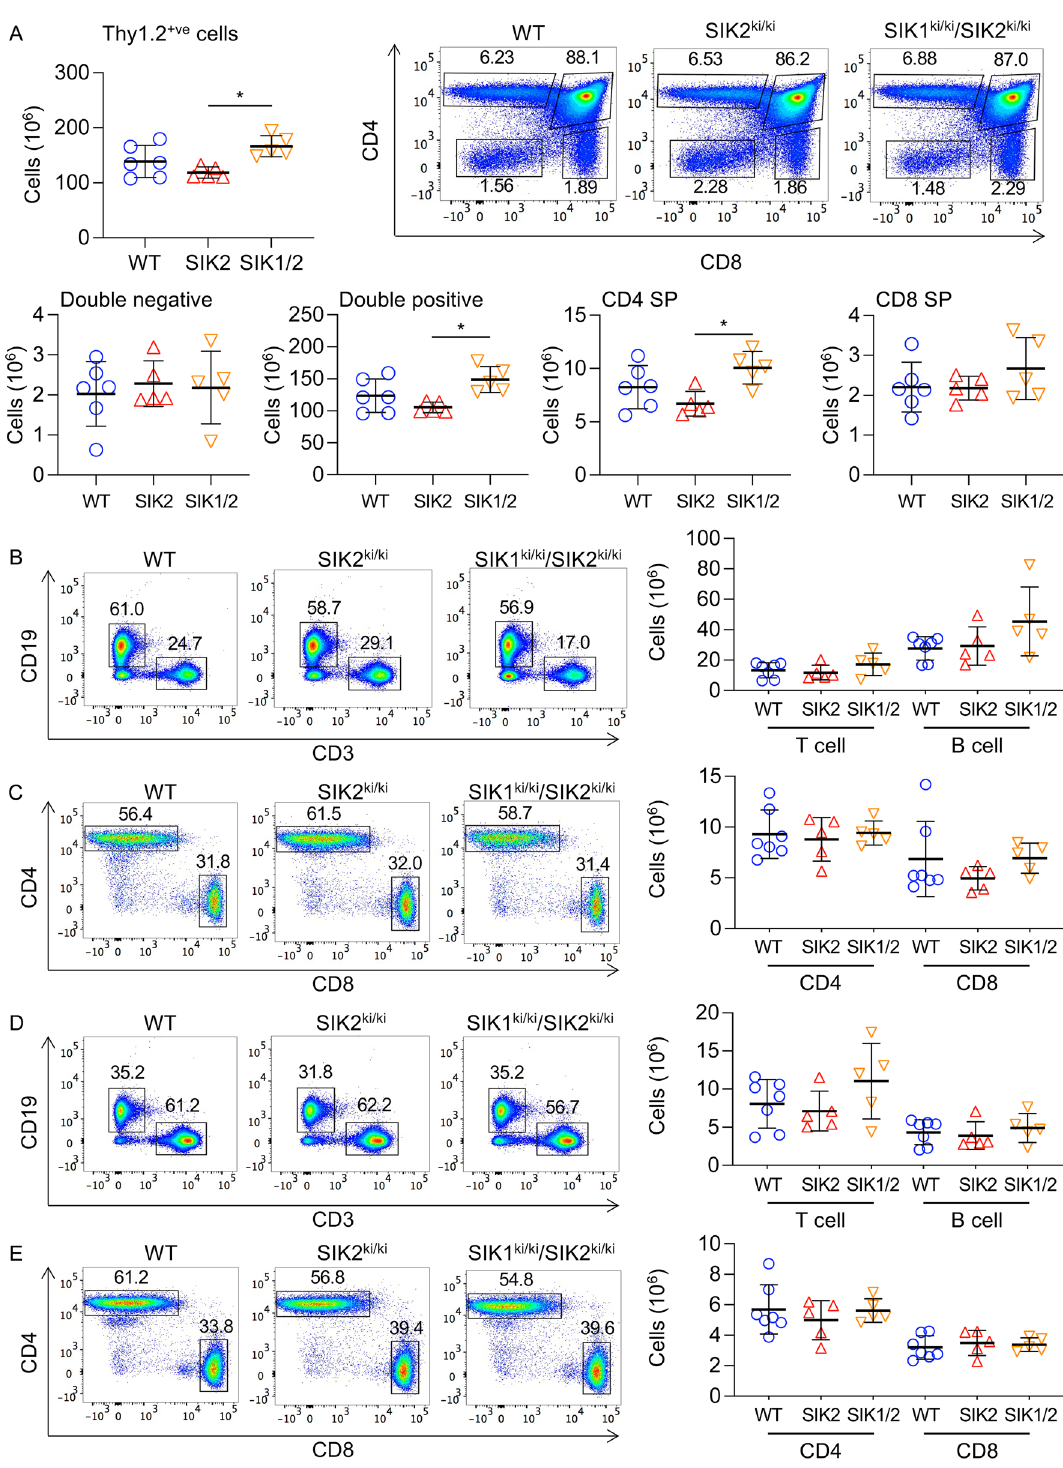
Figure 3. T cell development is not abrogated in SIK2 ki/ki and SIK1 ki/ki /SIK2 ki/ki mice. Thymi ( A ), spleen ( B , C ) and lymph nodes ( D , E ) were isolated from wild type (WT), SIK2 ki/ki (SIK2) and SIK1 ki/ki /SIK2 ki/ki (SIK1/2) mice and analysed by flow cytometry as described in the methods. ( A ) Representative CD4 / CD8 plots of Thy1.2 +ve cells in the thymus and graphs for absolute numbers of Thy1.2 +ve , DN, DP, CD4 SP and CD8 SP cells. ( B ) Numbers of CD3 +ve T cells and CD19 +ve B cells in the spleen, along with representative FACS plots. (C) Absolute numbers of CD4 and CD8 T cells and representative CD4 / CD8 plots of CD3 +ve T cells in the spleen. ( D ) Numbers of CD3 +ve T cells and CD19 +ve B cells in the lymph nodes, along with representative FACS plots. ( E ) Absolute numbers of CD4 and CD8 T cells and representative CD4 / CD8 plots of CD3 +ve cells in the lymph nodes. Graphs show mean with symbols representing measurements from individual mice. Differences in cell number between the different genotypes was analysed by RM two way ANOVA with Sidak’s post hoc testing except for the number of Thy1 +ve cells in A which was analysed by one way ANOVA. p < 0.05 is indicated by *, < 0.01 by ** and < 0.001 by ***. 5 SIK2 ki/ki and SIK1 ki/ki /SIK2 ki/ki mice were analysed along with 6 wild type thymi and 7 wild type